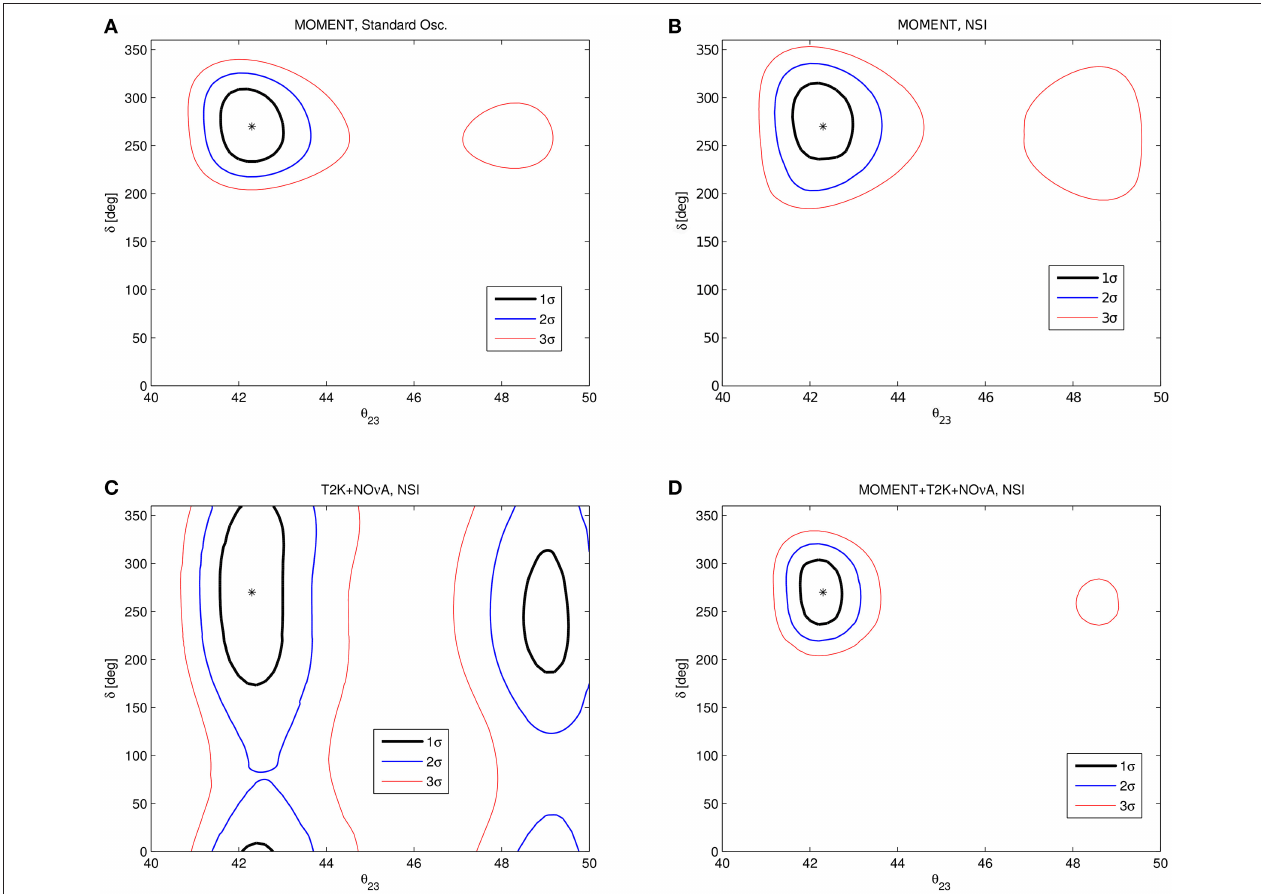
θ 23 projected for MOMENT, NO ν A and T2K. The stars mark the assumed true values of δ and θ 23 which are taken to be their present FIGURE 17 | Sensitivity to δ − best fit values [110]. Both appearance and disappearance modes are taken into account. For MOMENT, SF 0.1%. The star in each panel shows the assumed true = value. (A) shows the sensitivity of MOMENT for standard scenario without NSI. In (B–D) , pull method is used to treat the uncertainties of ǫ shown in Equations (59, 60). (B) displays the sensitivity of the MOMENT experiment alone. (C) shows the sensitivity of the NO ν A and T2K experiments combined and (D) demonstrates the combined sensitivity of all three experiments. Plots are taken from Bakhti and Farzan [234].